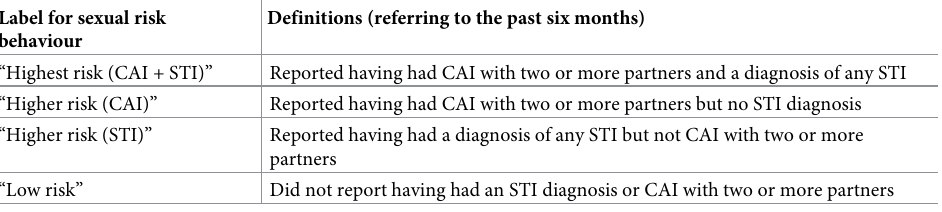
Table 1. Definitions of sexual risk behaviour groups, according to self-reported number of condomless anal inter- course partners and diagnosis of any sexually transmitted infection over the past six months. Label for sexual risk